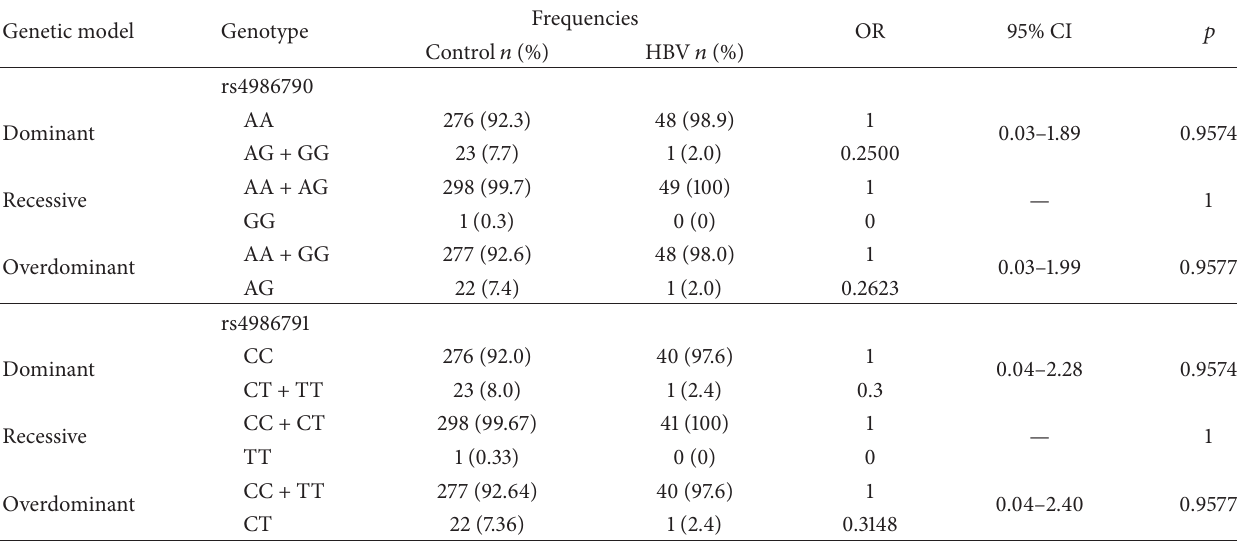
Table 4: Genetic models and risk of infection with HBV.